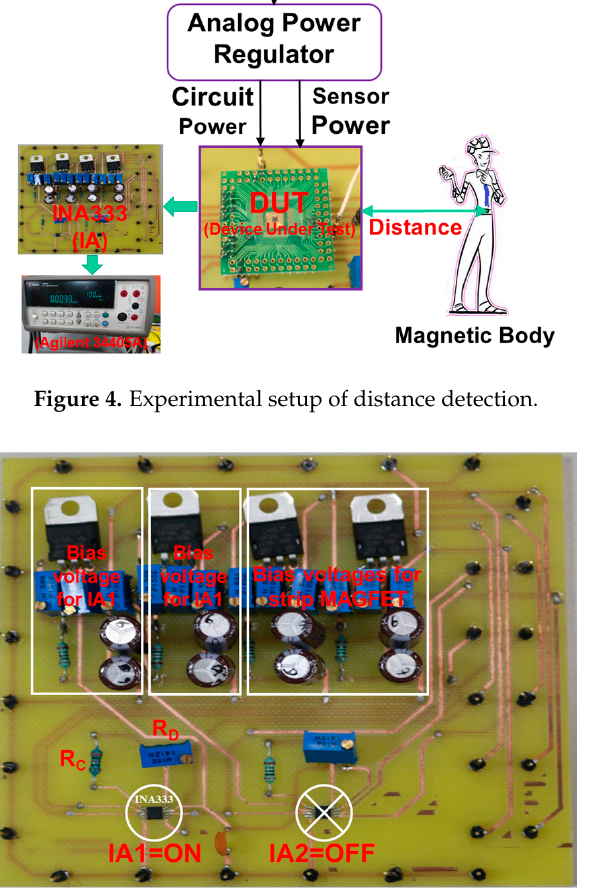
Figure 4. Experimental setup of distance detection.